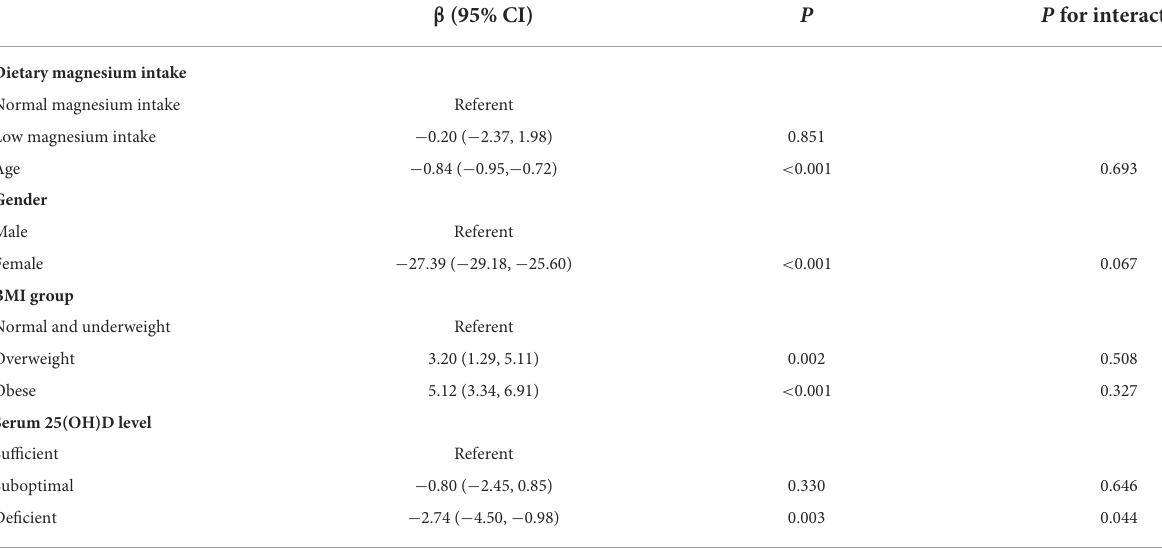
TABLE 2 Associations between low magnesium intake and handgrip